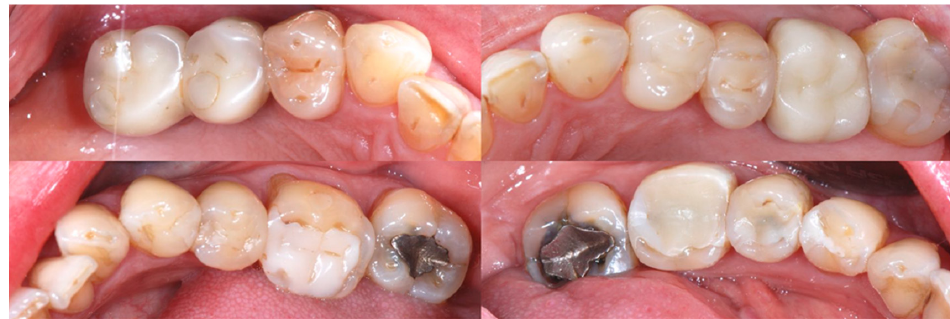
Figure 2. Incongruous conservative and prosthetic treatments visible at the occlusal surface of the posterior sectors.